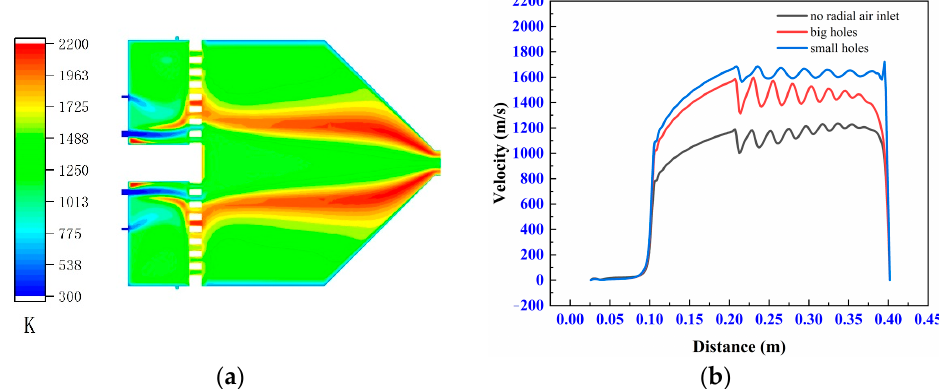
Figure 8. Contours of temperature without radial air inlets ( a ). The velocity at the central axis of the model with no radial inlets, big holes, and small holes in the ceramic sheet ( b ).